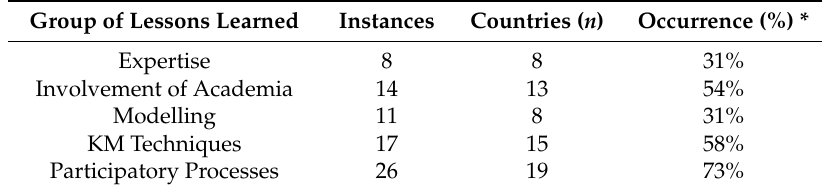
Table 10. Number of lessons learned by group and occurrences by